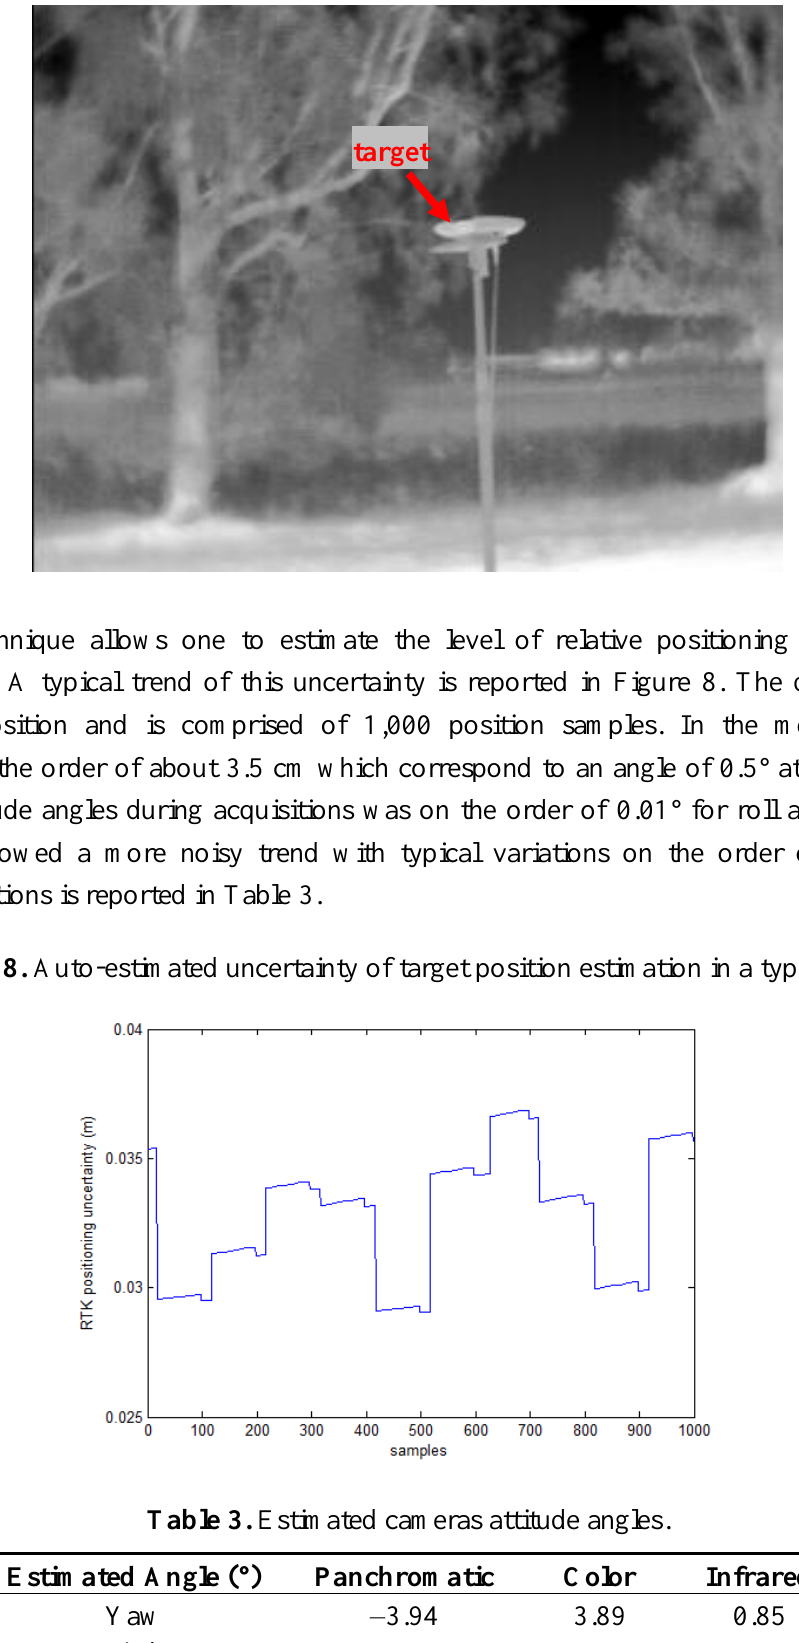
Figure 7. Example of thermal infrared image taken during alignment session.